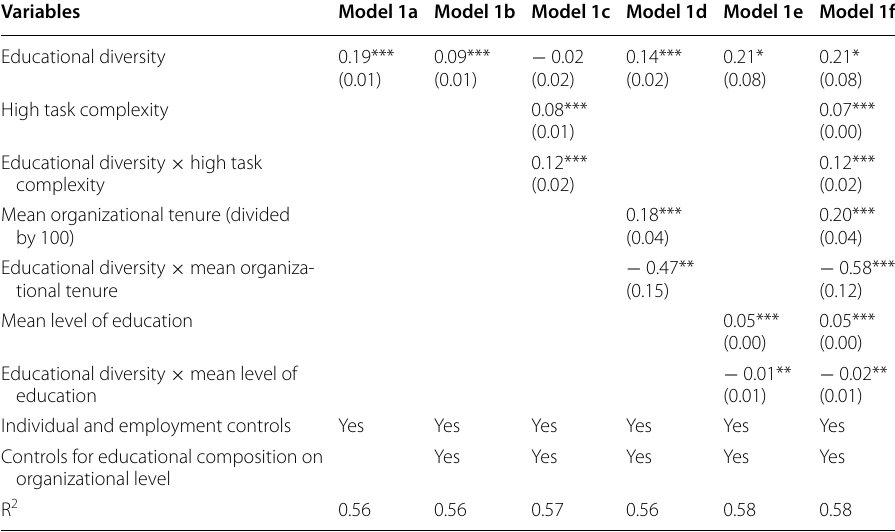
Table 3 Results for workers’